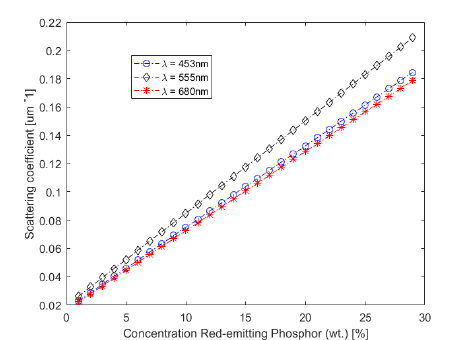
Fig. 2: Scattering coe(cid:30)cients of α -SrO · 3B 2 O 3 :Sm 2+ versus concentration red phosphor (%)